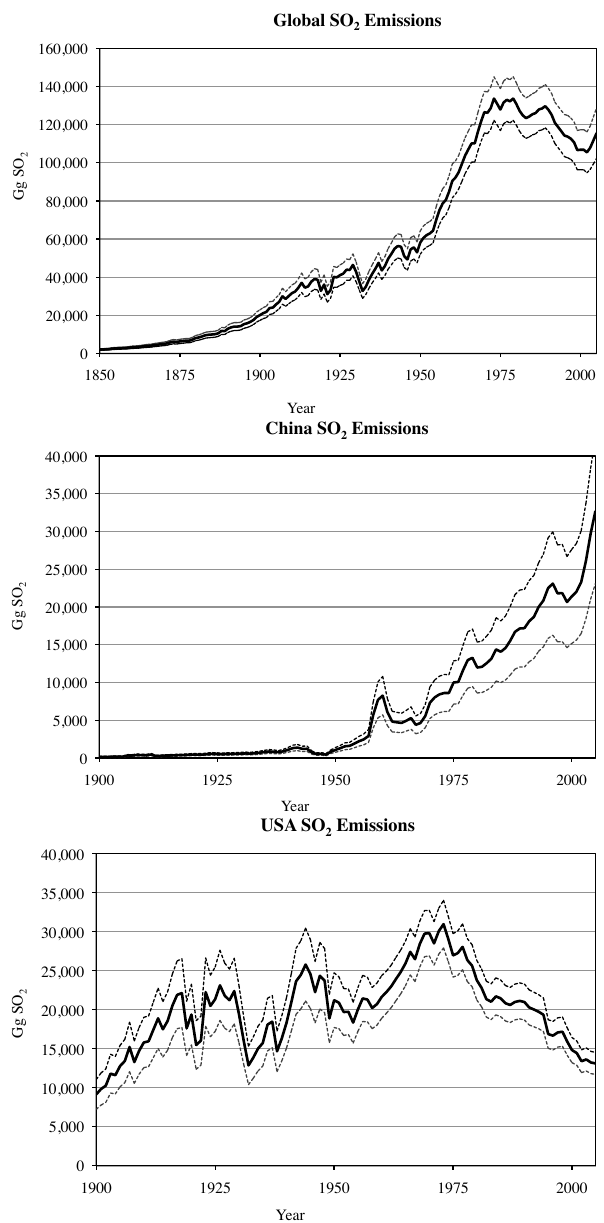
Fig. 3. Sulfur dioxide emissions from fuel combustion and process emissions with central value (solid line) and upper and lower un- certainty bounds (dotted lines). (a) Global, (b) China, and (c) USA. China and USA graphs exclude shipping